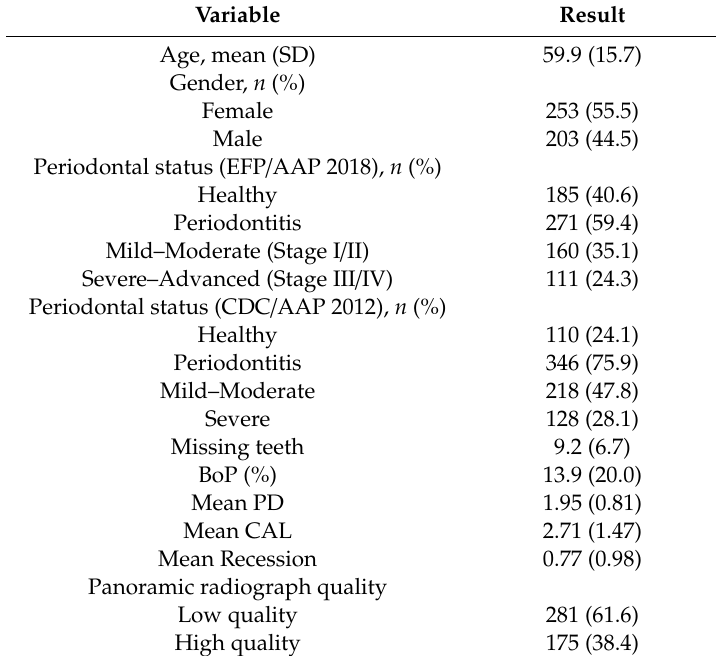
Figure 2. Flowchart of participants. Table 2. Demographic and clinical characteristics of participants ( n = 456), with periodontitis severity distribution according to the EFP/AAP 2018 and CDC/AAP 2012 case definitions.